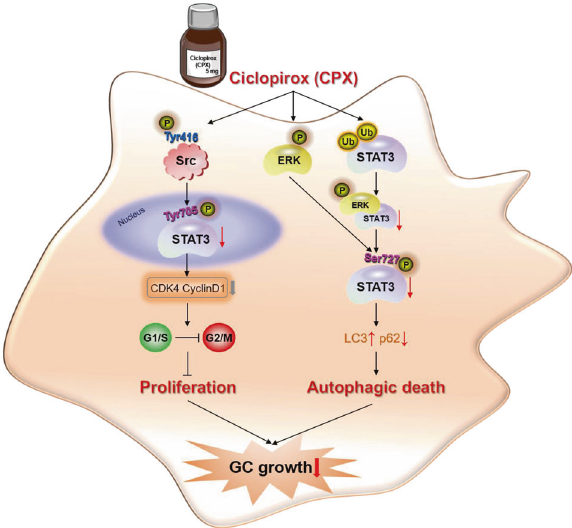
Fig. 7 The proposed antitumorigenic mechanism of CPX on GC growth. CPX treatment induces cell cycle arrest and then inhibits GC cell proliferation by regulating the p-Src (Tyr416)/p-STAT3 (Tyr705) pathway. Moreover, CPX enhances autophagic death by inducing total STAT3 ubiquitination and decreasing p-STAT3 (Ser727) levels in GC